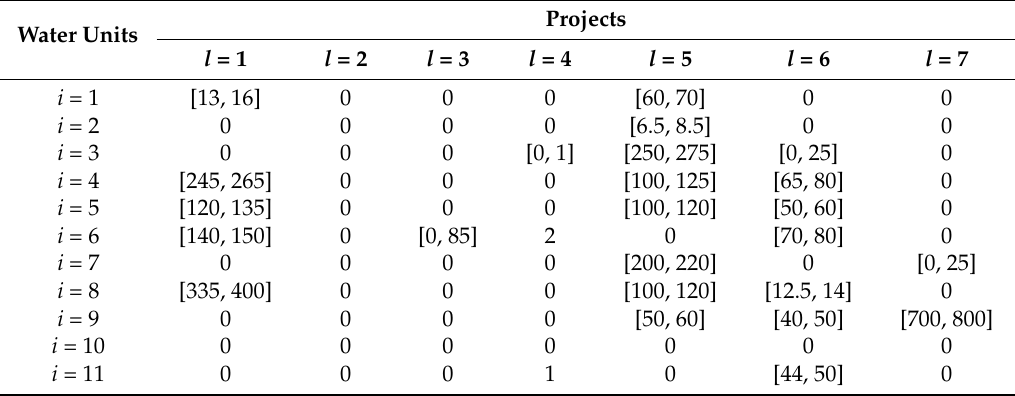
Table 7. Projects for improving the water environment carrying capacity in the Yinma River. Water